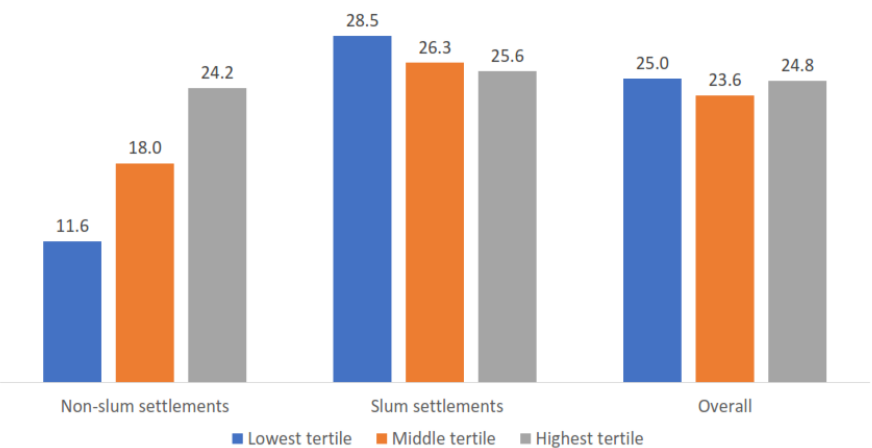
Figure 2. Contraceptive prevalence rate by wealth index and type of neighborhoods. Within nonslums, fewer of the youngest and least-educated groups used modern contraceptives. Bivariate associations showed that women with higher education had a higher prevalence of modern contraceptive use than that of uneducated women. Regard- ing religion, there was a lower percentage of modern contraceptive users among Evangel- ical and Catholic groups than that among Protestants. Within slums, teenagers and those classified as having other ethnic affiliations had a lower percentage of modern contracep- tive users. In slum neighborhoods, the least-educated women had the highest prevalence of modern contraceptive use, contrary to expectations (Table 2) The unmet need for FP services was 11%, and total demand was 54%. In slum neigh- borhoods, there was a higher level of unmet need (12% vs. 8%, p < 0.001) and total demand (58% vs. 48%, p < 0.001) compared to that in nonslum neighborhoods (Figure 3). Figure 3. Unmet need and total demand by type of neighborhood.